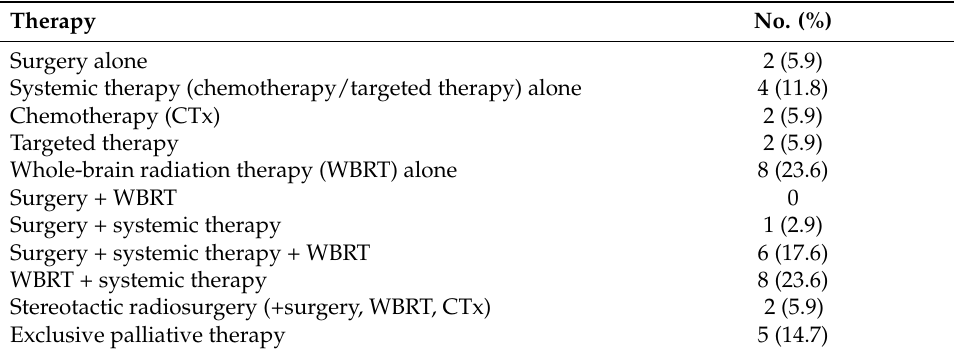
Table 3. Treatment modalities for patients with brain